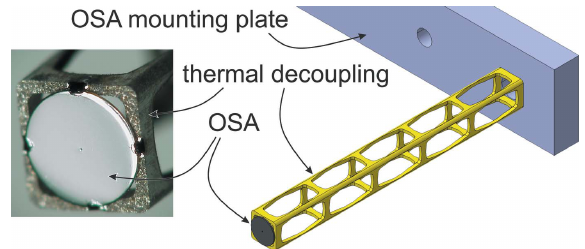
Figure 5 Left: micrograph of the designed OSA having an outer dimeter of 1.65 mm and holder. Right: the OSA is welded to a wire-eroded thermal decoupling structure (yellow) fixed on a temperature-controlled mounting plate.